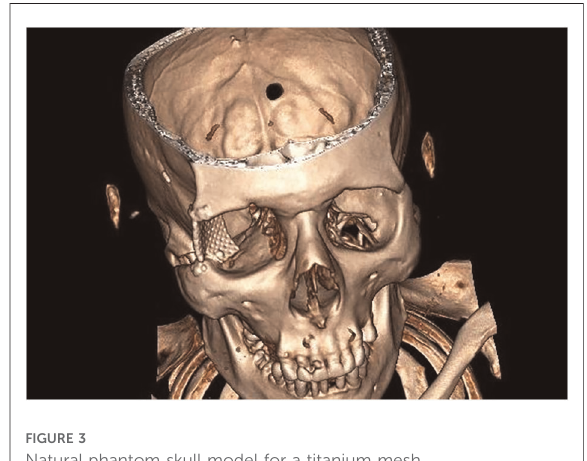
FIGURE 3 Natural phantom skull model for a titanium